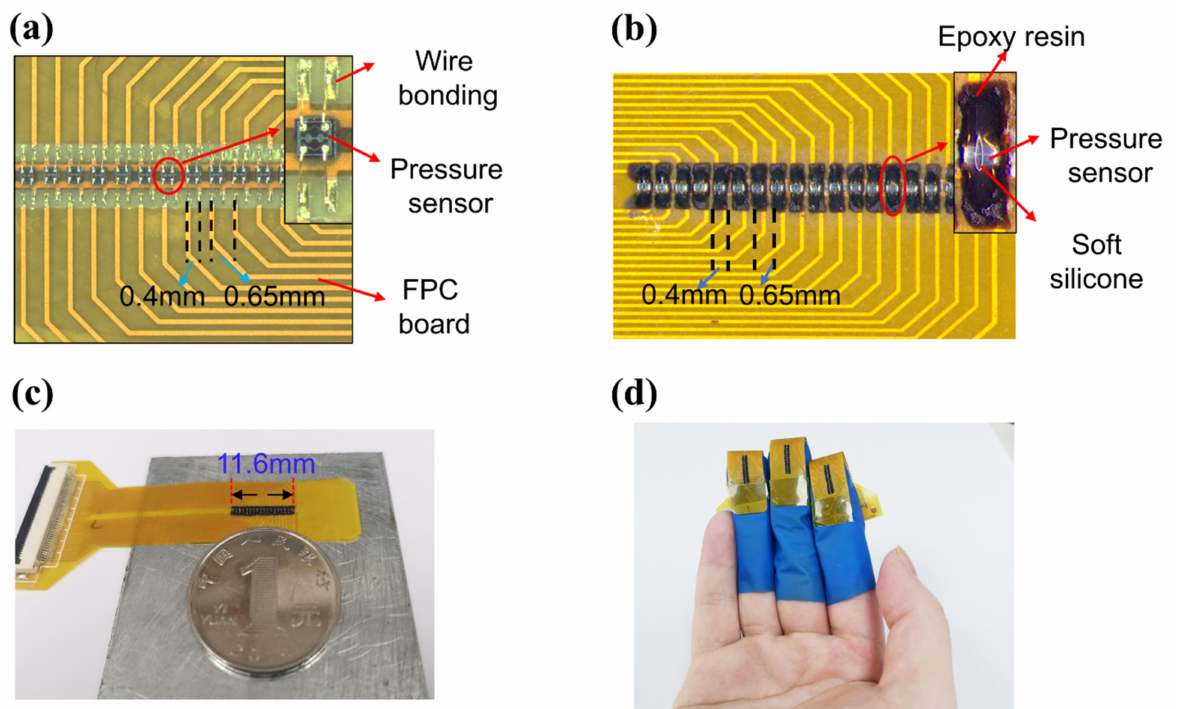
Figure 3. Sensor array packaging procedure. ( a ) Sensors were attached to the FPC board and bonding wire. ( b ) The pressure sensor was coated with silicone and epoxy resin. ( c ) The whole pulse sensor array and FPC board with a coin for scale. ( d ) Pulse sensor arrays are small enough to be worn on the fingers.